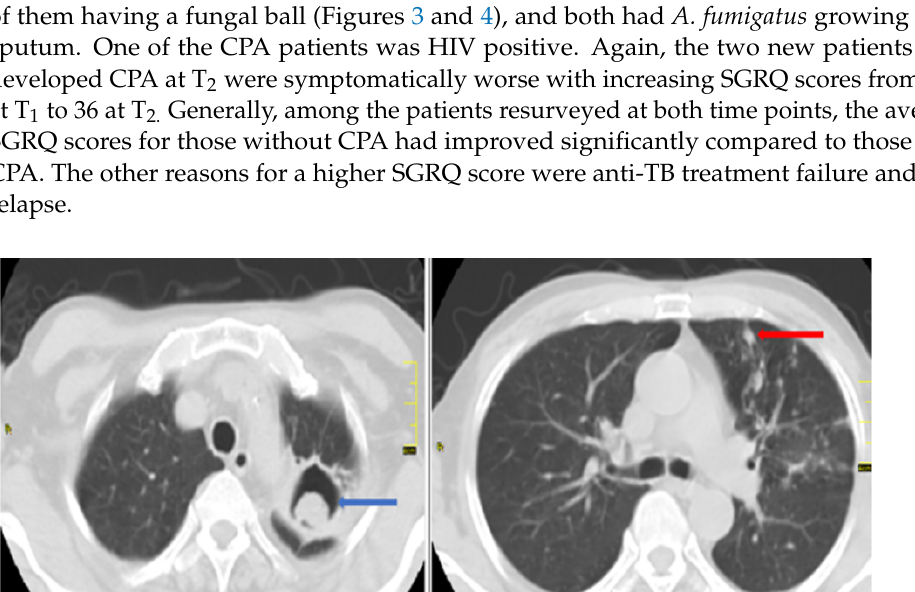
Figure 3. Axial contrast CT scans, axial lung window of chest of another CPA patient diagnosed at T 2 showing ( A ) a soft tissue mass within a left apical lung cavity (blue arrow) with a characteristic crescent of air around it, the ‘Monod sign’, indicative of an aspergilloma. ( B ). Nodular opacities (red arrow) and non pericavitary fibrotic changes in the left upper lobe.